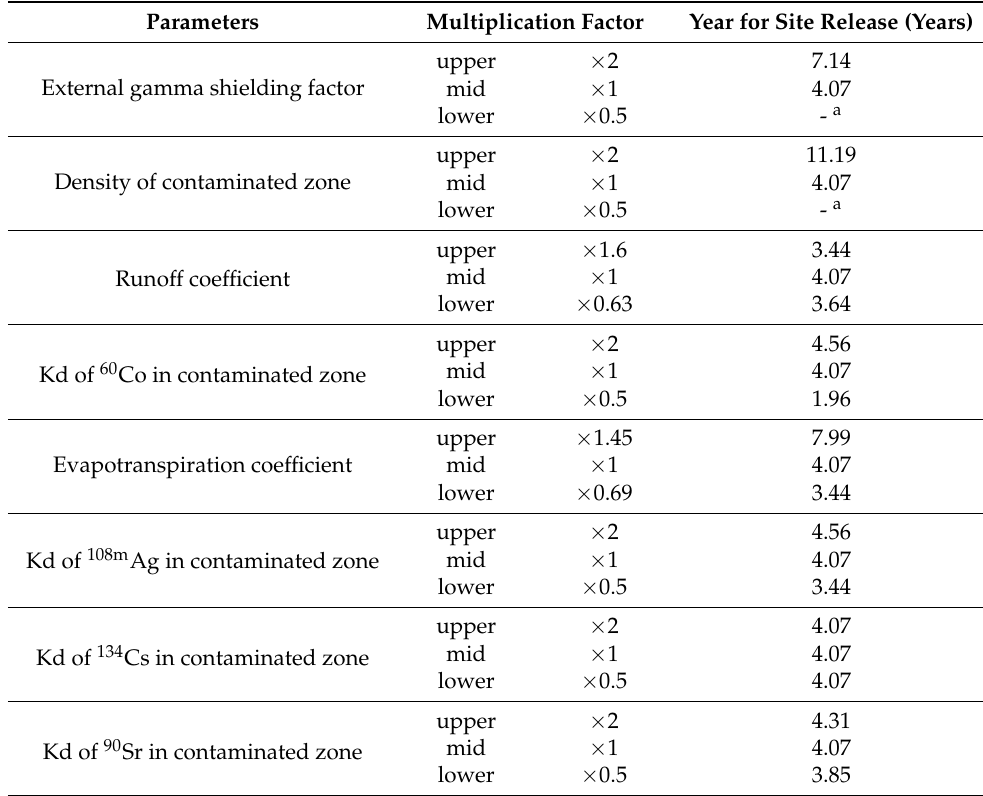
Table 7. Year for site release for the unrestricted reuse of Wolsong NPP site calculated based on the sensitivity analysis for various input parameters. Parameters Multiplication Factor Year for Site Release (Years) External gamma shielding